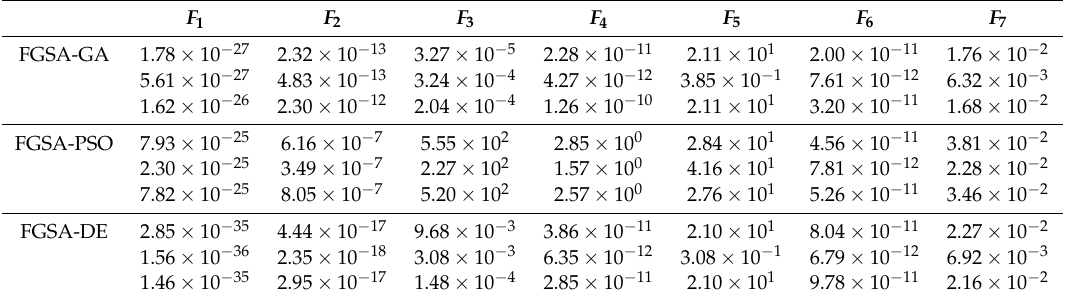
Table 3. Comparisons between FGSA-GA, FGSA-PSO and FGSA-DE over 30 runs for unimodal functions.